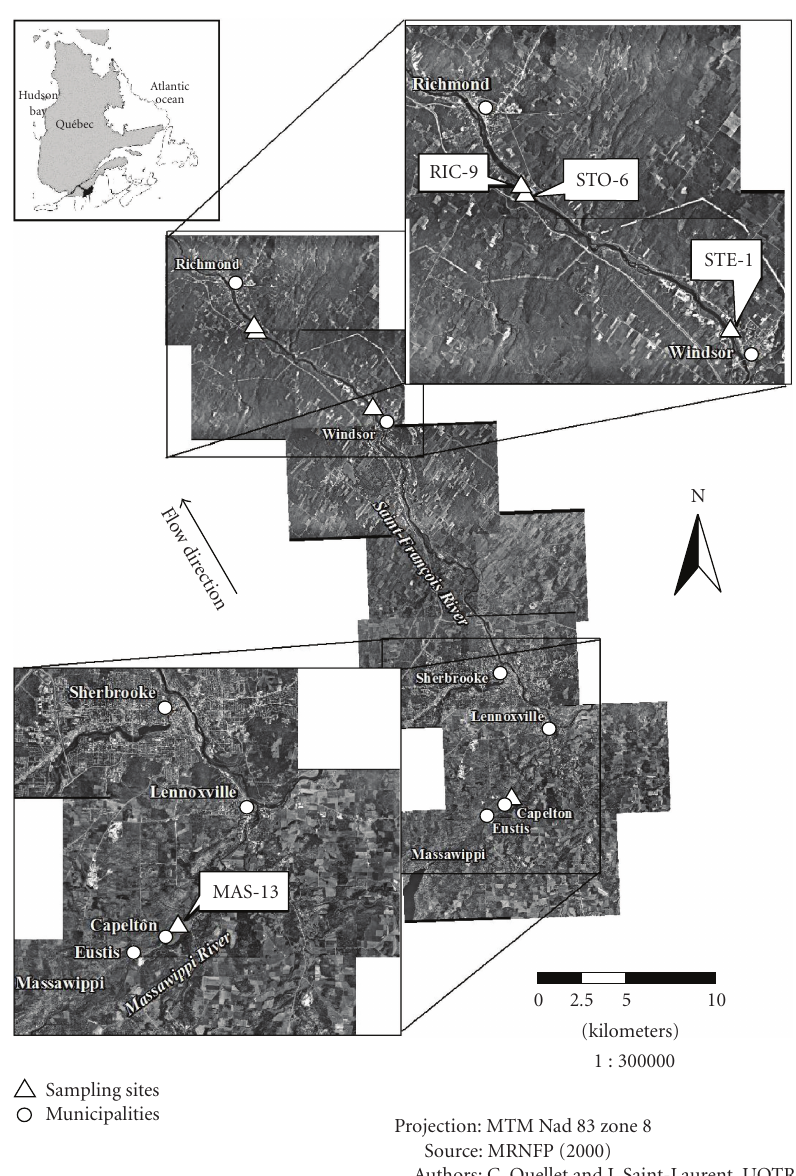
Figure 1: Study area and location of the sampling sites at Richmond (RIC-9, STO-6), Windsor (STE-1) and Massawippi (MAS-13) in southern